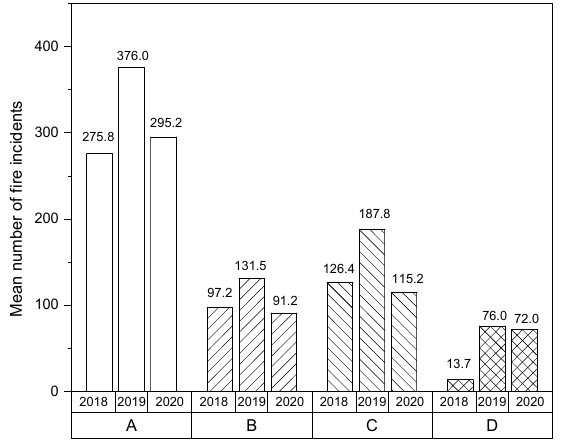
Figure 3. Mean number of fire incidents reported from 2018 to 2020 for selected fire stations in all categories (A, B, C and D).